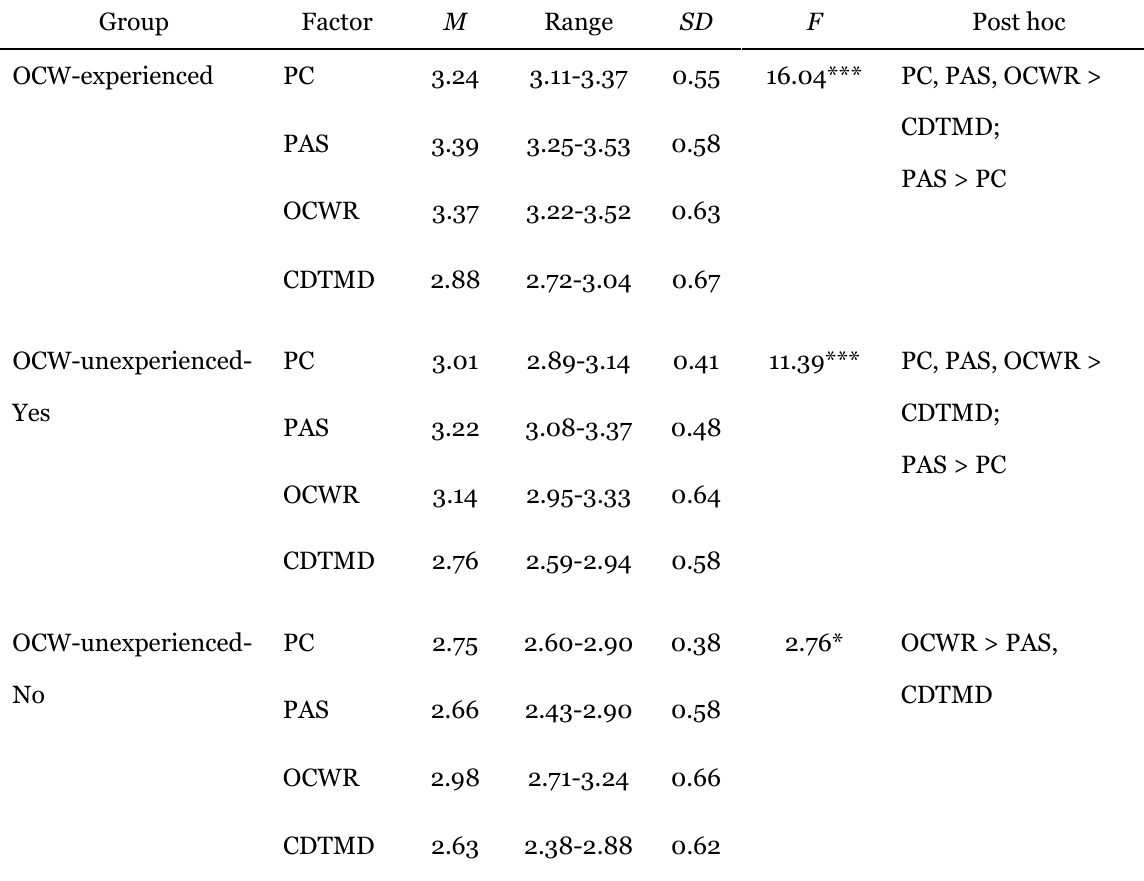
Results of a Multivariate Repeated One-Way ANOVA and Post Hoc Test of the TRS-OCW Regarding the Three Faculty